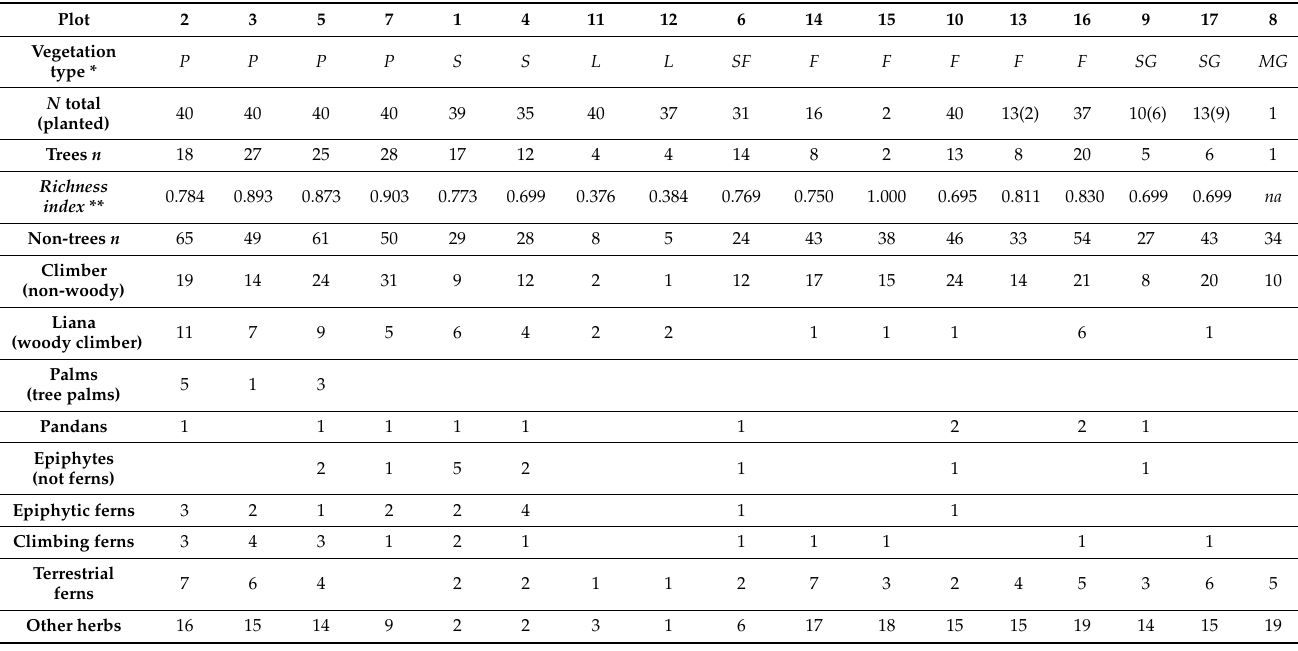
Table 3. Stem counts ( N , trees ≥ 10 cm diameter at 1.3 m height (dbh)), species counts ( n ) by lifeform, and richness by